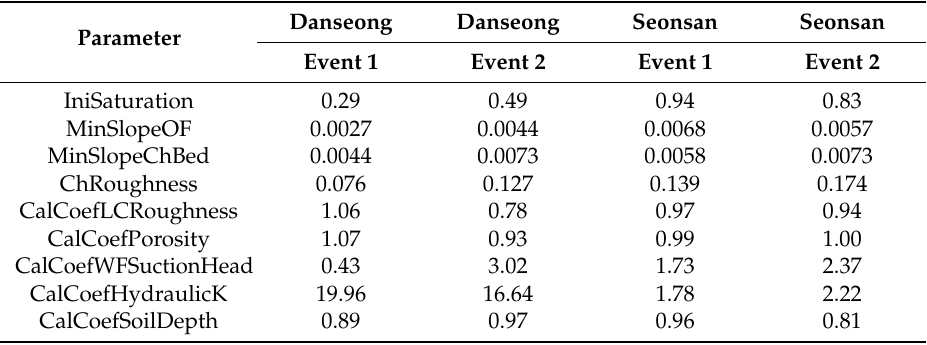
Table 5. Best parameter values.